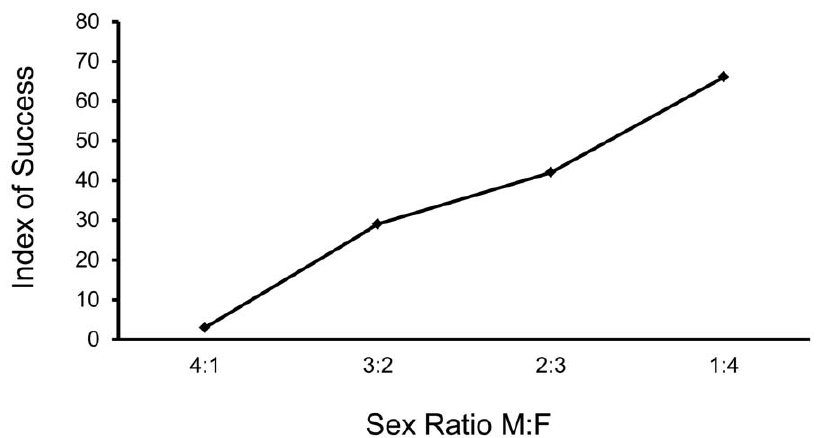
Figure 1. Predicted relationship between sex ratio for fishers that are released and reintroduction success. The VORTEX model included stochastic variation and was run for 100 years. Twenty fishers were modeled to be released in each of 5 years in 4 groups of 5, with each group released into a different site. doi:10.1371/journal.pone.0032726.g001 PLoS ONE |